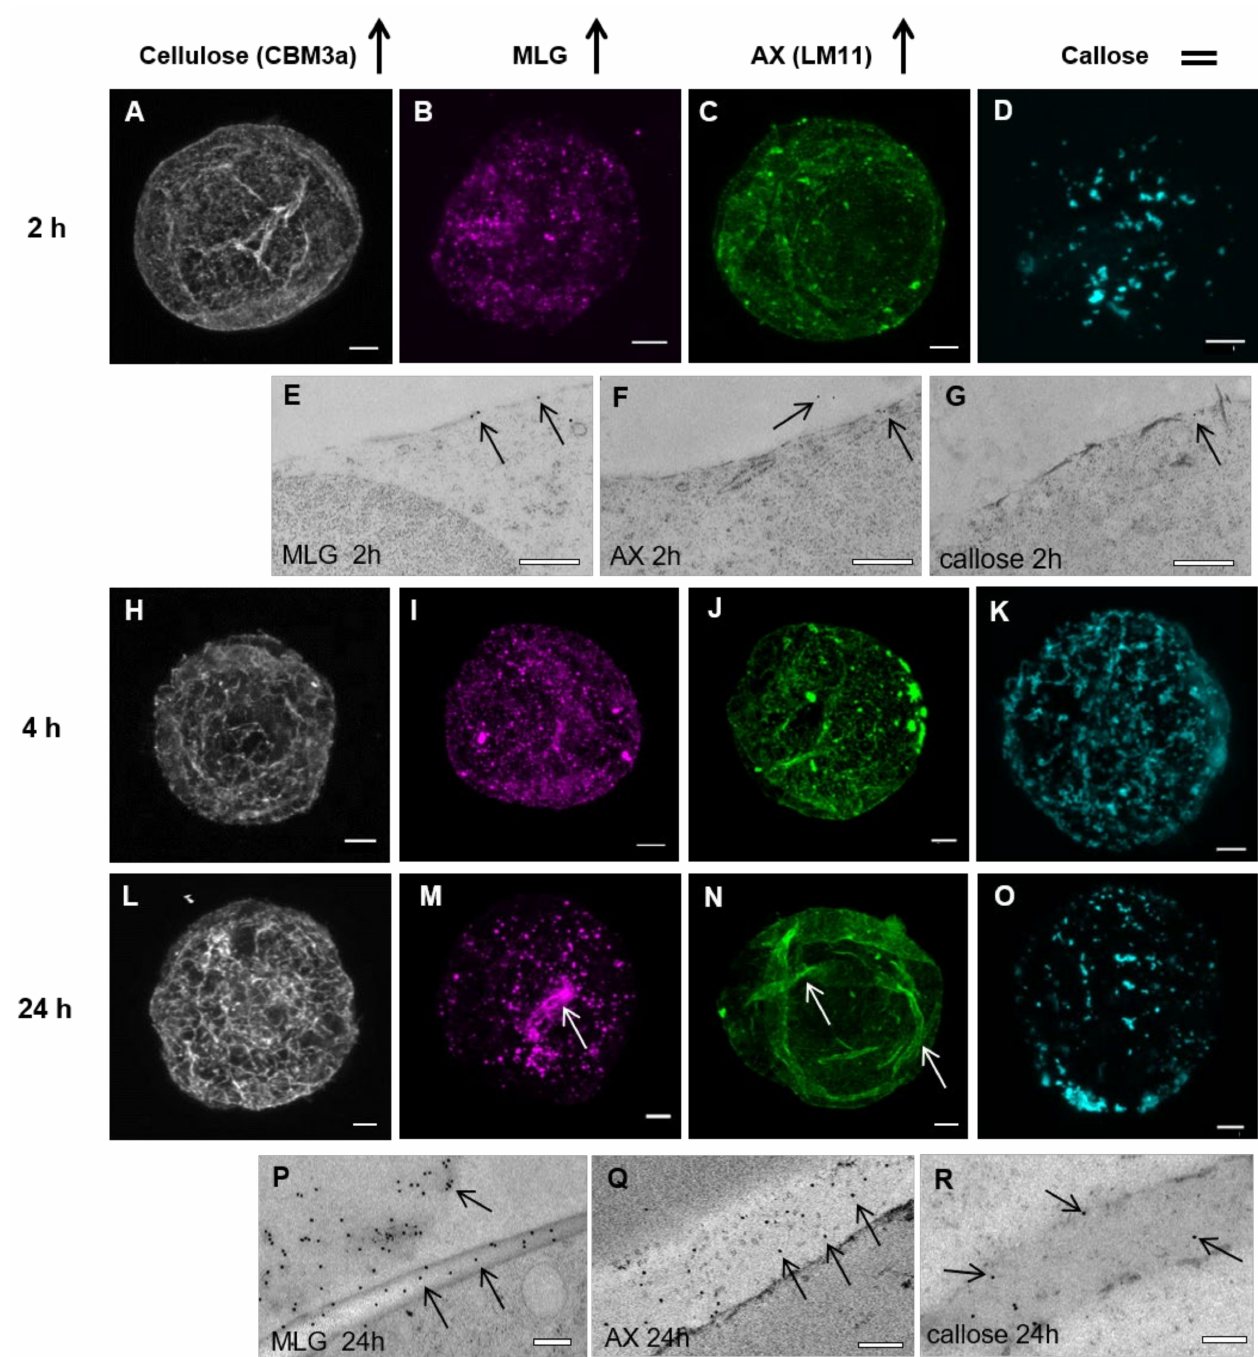
Figure 3. LSM and TEM images of antibody labeling at 2, 4, and 24 h. Continuing deposition of the polysaccharides at the 2 h ( A – G ), 4 h ( H – K ), and 24 h ( L – R ) time points. Cellulose ( A , H , L ), MLG ( B , E , I , M , P ), and AX ( C , F , J , N , Q ) all continued to be deposited throughout the time course studied and visibly accumulated at the walls (arrows in TEM images). Clusters of MLG labeling (M; white arrows) are observed at 24 h, but these are punctate points at a higher magnification. Similar aggregations of filaments are present for AX (N; white arrows). Interestingly, callose deposition ( D , G , K , O , R ) appeared not to increase, but stayed fairly constant throughout the time course. Scale bars = 5 µ m ( A – D , H – O ) and 200 nm ( E – G , P – R